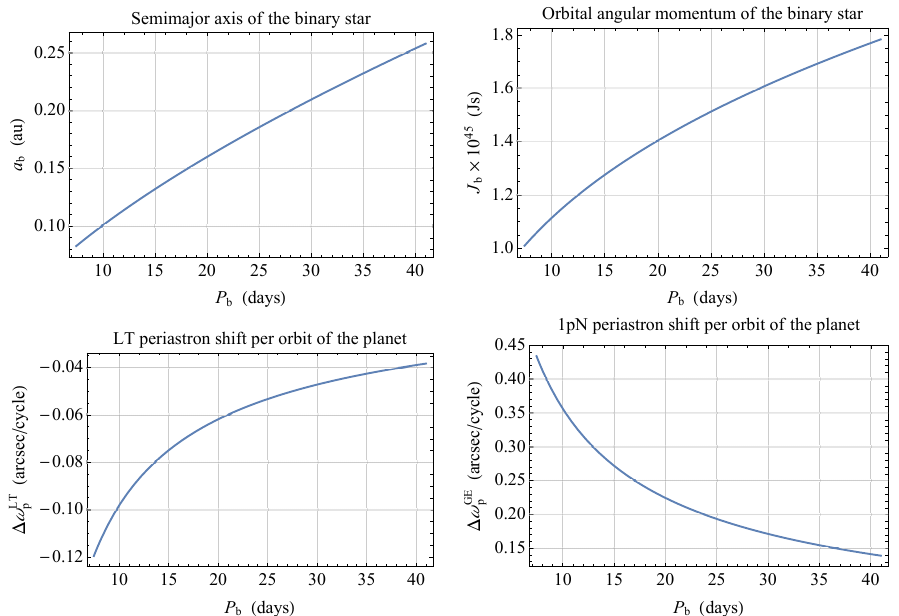
Figure 2. Upper row: binary’s semimajor axis a b , in au, and orbital angular momentum J b , in Js, as functions of the binary’s orbital period P b ranging from 7.44 to 41d. Lower row: planet’s gravitomagnetic and gravitoelectric net shifts per orbit, in arcseccycle − 1 , as functions of the binary’s orbital period P b ranging from 7.44 to 41d. The orbital stability condition a p = 2 a b was adopted along with M A = 0.69 M (cid:12) = 1.03 M B , e b = 0.023, M p = M , e p = (cid:88)